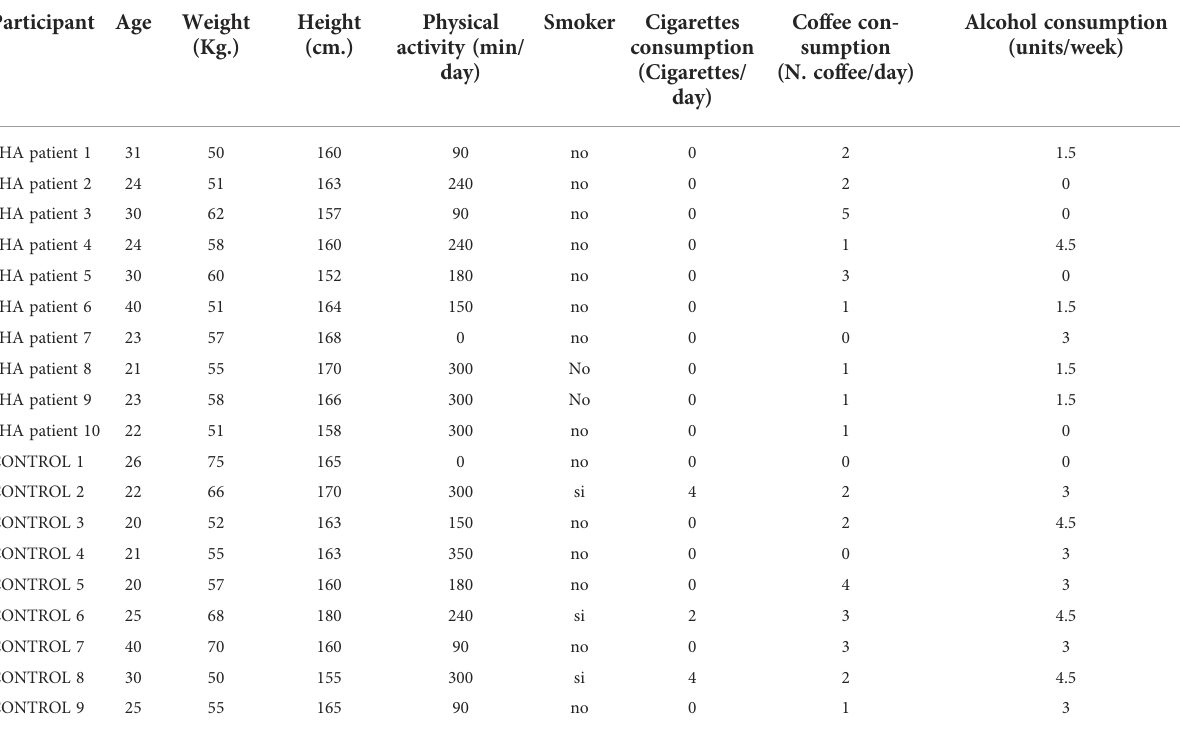
Demographic, anthropometric and consumption habits of the experimental sample. Participant Age Weight Height Physical (Kg.) (cm.) activity